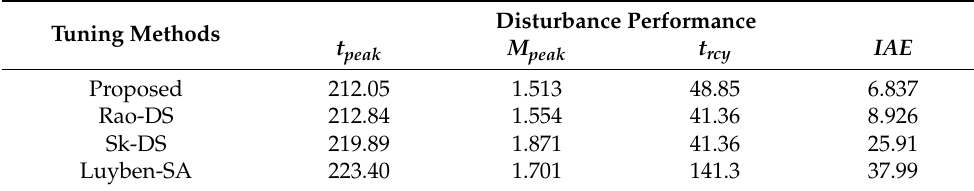
Table 4. Quantitative comparison of responses to disturbance in PIPTD with − 10% parameter mismatch.